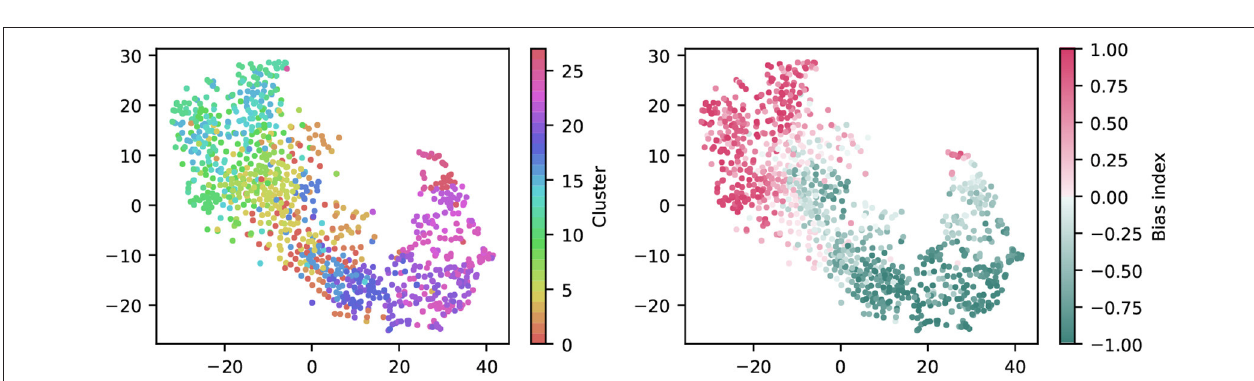
FIGURE 6 | Visualization of the clustering with t-SNE embeddings of the chirp responses. A t-SNE embedding was generated from chirp PSTHs (bin size 50 ms; perplexity 30). Each unit is colored either by cluster membership (left) or by bias index (right) . Note that similar colors in the cluster plot are perceptually hard to distinguish, colors were chosen such that a similar hue indicates proximity in the cluster dendrogram. The color coding is the same as in Figure 7